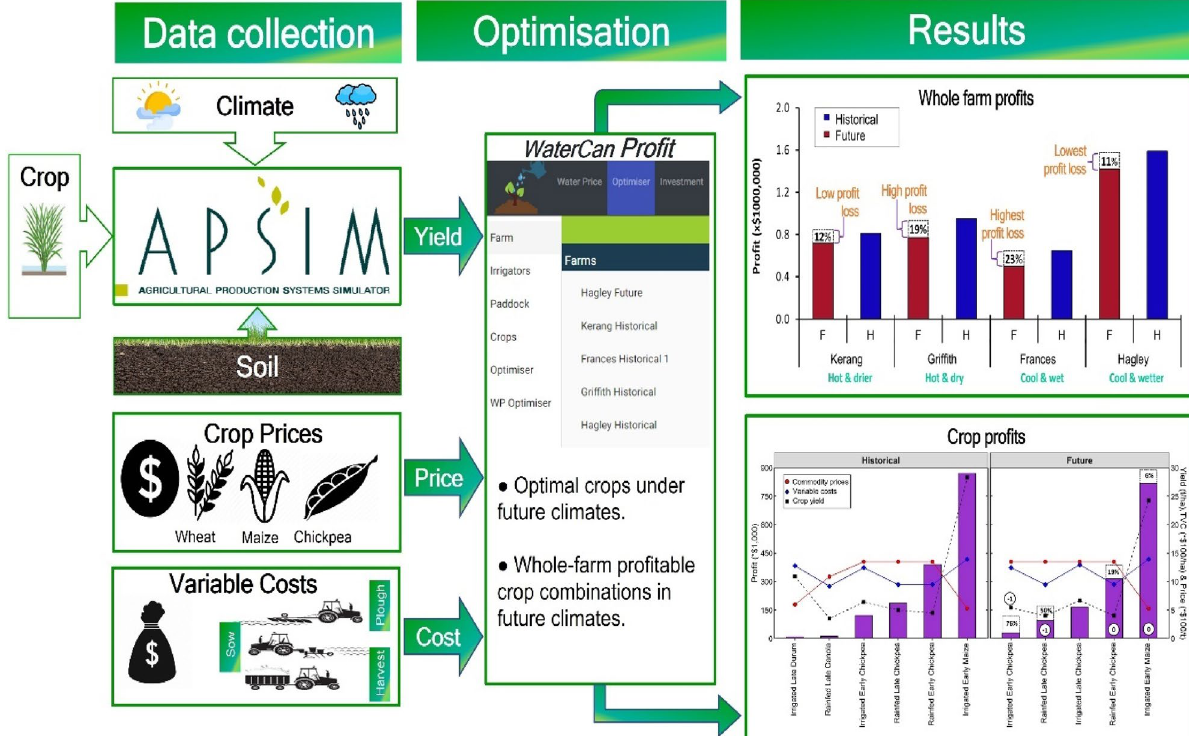
Figure 1. Summary diagram indicating strategic whole farm planning that accounts for crop genetics, biophysical and economic factors can optimise profit despite increasingly frequent extreme climatic events under the climate crisis. Using the Agricultural Production Systems SIMulator (APSIM), we simulated the combined effects of climate change and extreme climatic events on crop yields. A new decision support tool— WaterCan Profit optimised crop type and areas that collectively maximised farm profit under historic (1985– 2004) and future (2070–2089) climates across four representative irrigated cropping environments in Australia.